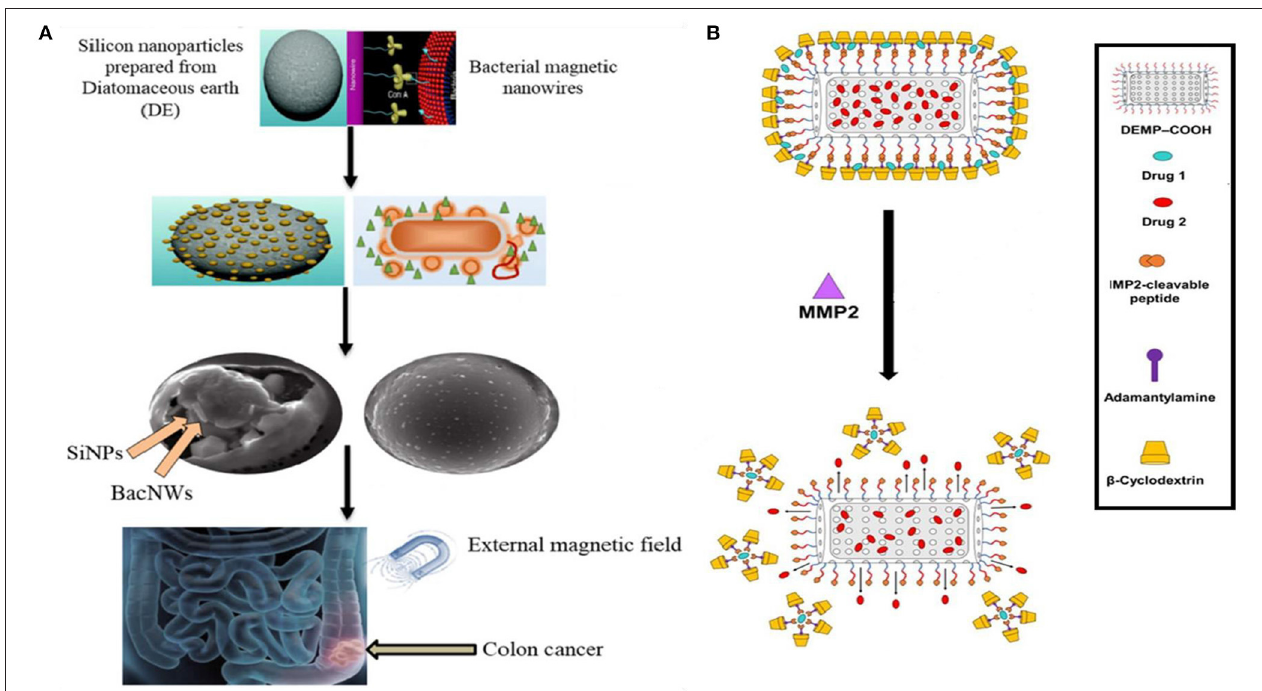
FIGURE 3 | Application of Diatom based NPs in drug delivery. (A) Dual drug chemotherapy approach using Diatomaceous SiNP and bacterial magnetic nanowires. The drugs are released specifically in the colon region in pH responsive manner and under magnetic field (Maher et al., 2017). (B) The drugs were encapsulated in Diatomaceous Earth Microparticles (DEMP) either in siliceous core or in β -CD and Adamantane ( β -CD:Ad) micelles. Matrix MetalloProteinases-2 (MMP-2) specific peptide substrate was used as a linker between DEMPs core and β CD:Ad shell for stimuli responsive drug release into tumor tissue (Kabir et al.,